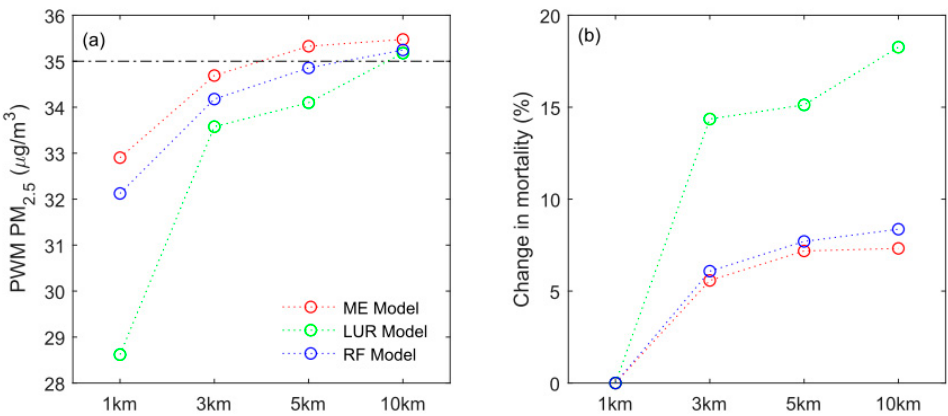
Figure 8. ( a ) Annual population-weighted mean (PWM) PM 2.5 and ( b ) difference in attributable mortality as a function of spatial resolution. Red, green and blue lines in each panel represent results estimated by the mixed effects (ME), the land-use regression (LUR) and the Random Forest (RF) models, respectively.